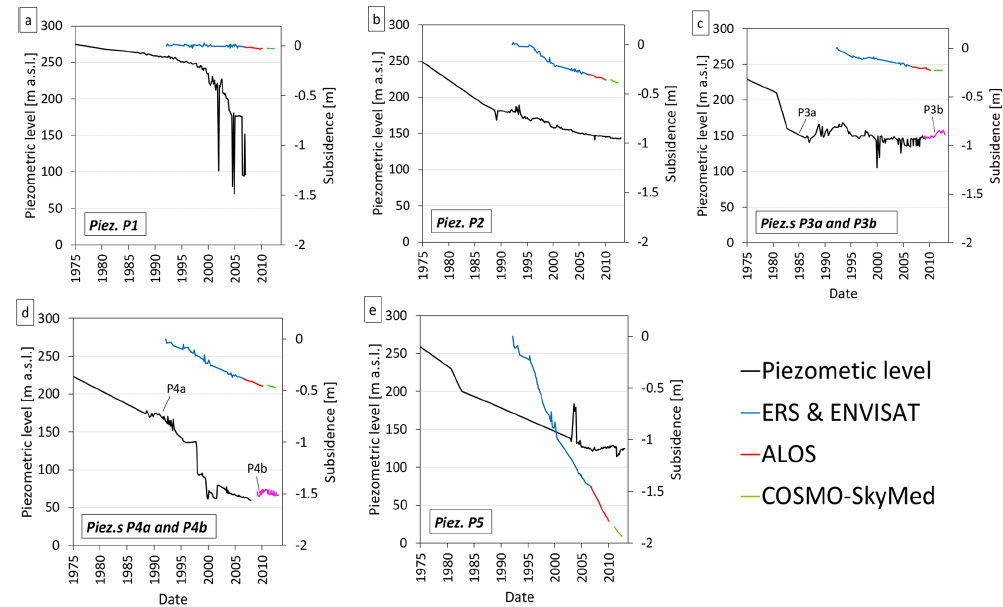
Figure 2. Comparison of the water level variations from 1975 to 2012 (black and pink line) at the different piezometers located on Fig. 1a, and the vertical displacements detected by the satellite sensors (blue, red and green